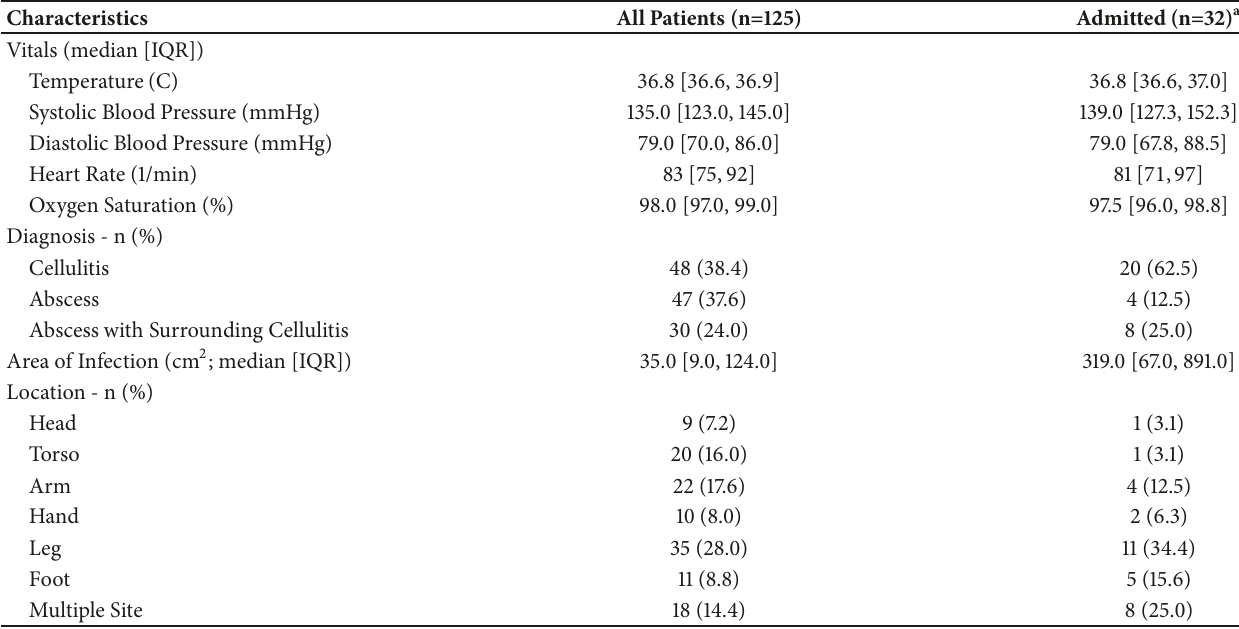
Table 2: Clinical characteristics of enrolled patients.